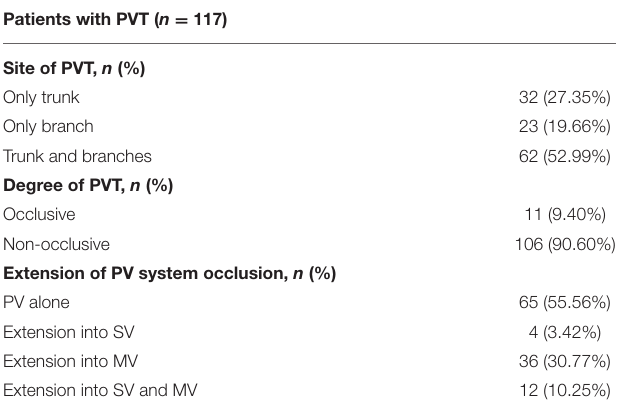
TABLE 3 | Propensity-matched study